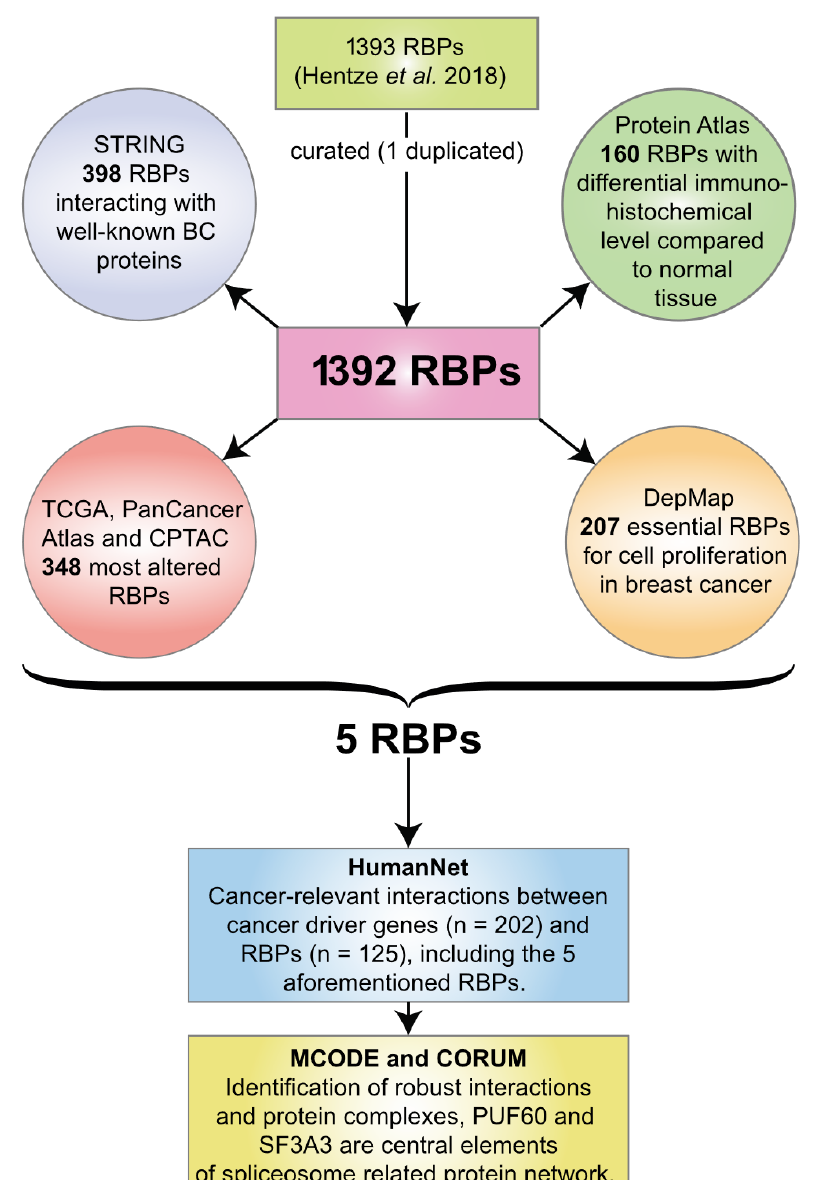
Figure 1. Workflow of the prioritization strategy. This scheme describes all major steps performed to identify PUF60 and SF3A3 as new spliceosome-related breast cancer RNA-binding proteins. identify PUF60 and SF3A3 as new spliceosome-related breast cancer RNA-binding